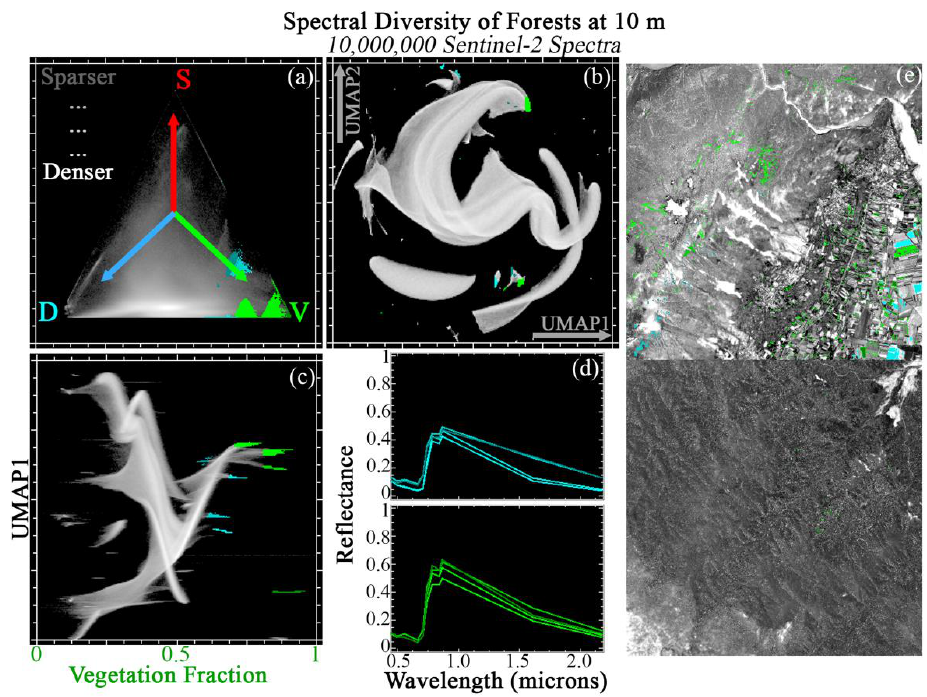
Figure 8. Joint characterization of forests (1). 10 × 1 megapixel Sentinel-2 tile subsets are selected from global forest diversity hotpots and analyzed at full 10 m pixel resolution. These spectra pref- erentially occupy the V to D apexes of the SVD mixing space ( a ), leaving the S portion of the space relatively sparse. The global 3-endmember linear mixture model fits these spectra better than the agricultural spectra (here, > 99.9% of spectra with <5% RMSE). UMAP ( b ) captures both subtle mix- ing continua and discrete clusters, but does not offer physical interpretability. Joint characterization ( c ) uses the physical meaning of the Vegetation mixture fraction to contextualize the subtle statistical